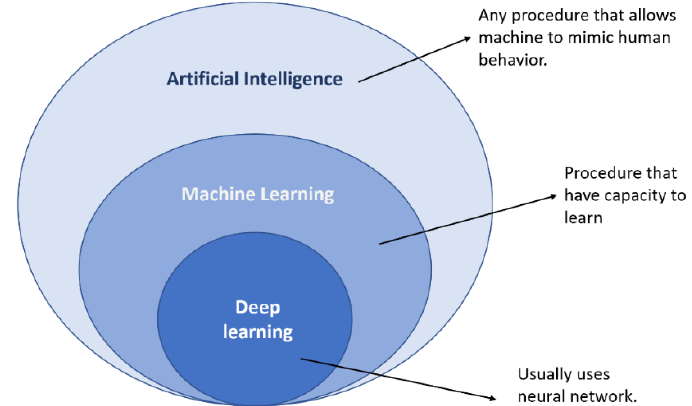
Figure 2. Machine learning and artificial intelligence